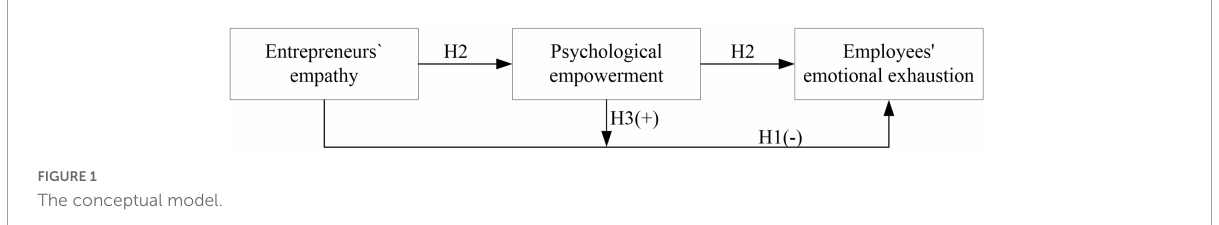
FIGURE1 The conceptual